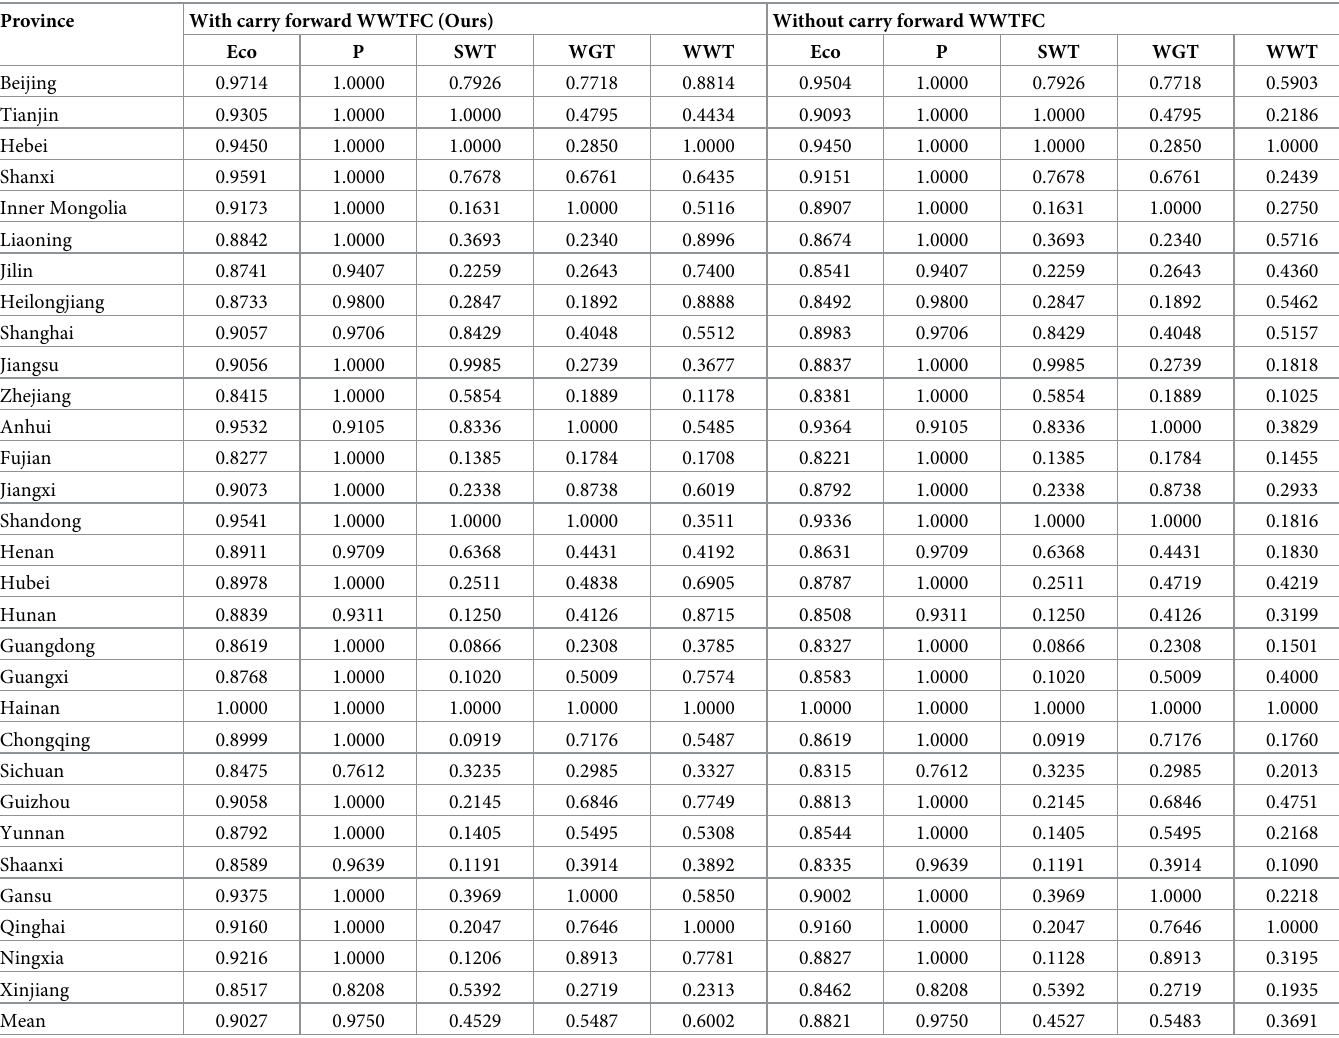
Table 5. Efficiency results with and without carry forward